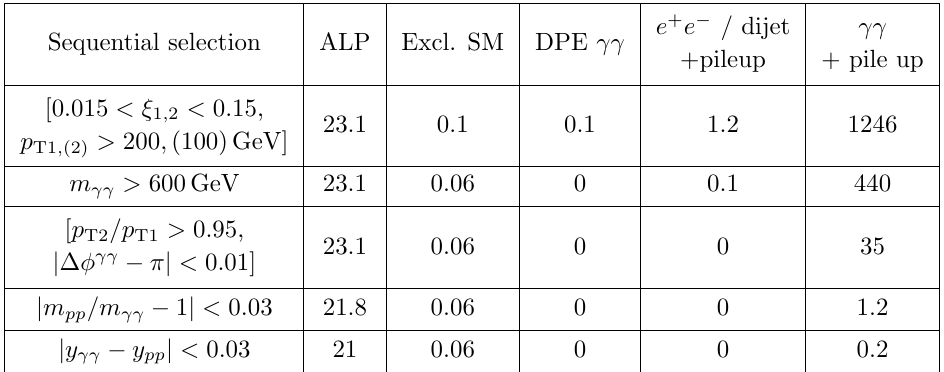
Table 1 . Signal and background yields after applying the event sequential selections. For il- lustrative purposes, we choose an ALP with mass m a = 1200 GeV and a coupling value of f (cid:0) 1 = 0 : 1 TeV (cid:0) 1 . We assume an integrated luminosity of 300 fb (cid:0) 1 an average of 50 additional in- p teractions per bunch crossing at s = 13 TeV. Excl. stands for the exclusive backgrounds and DPE for double pomeron exchange background. Non-exclusive diphoton overlapped with soft di(cid:11)ractive protons (rightmost column) constitute the dominating background. The (cid:12)rst two rows correspond to the diphoton o(cid:15)ine preselection. The third row corresponds to the elastic selection. The last p two rows correspond to the exclusive selection, with m pp = (cid:24) 1 (cid:24) 2 s and y pp = 1 log( (cid:24) 1 ). 2 (cid:24) 2